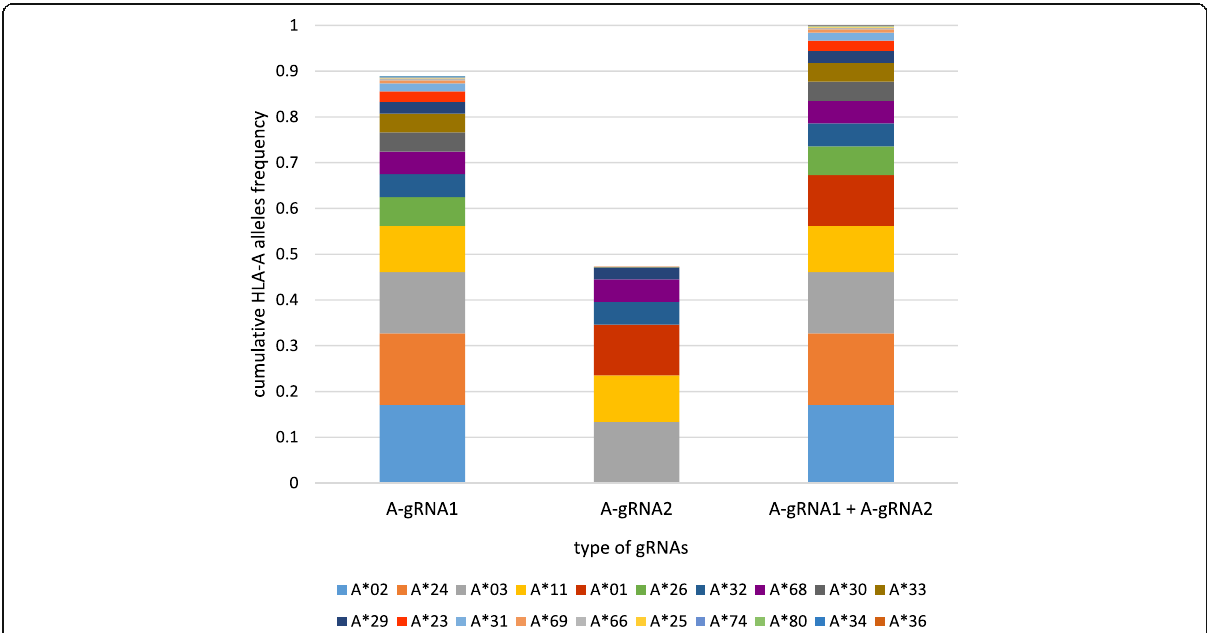
Fig. 2 Coverage of gRNAs for HLA-A alleles based on the frequencies in the Iranian population. Each column represents the possibility of each gRNA binding to its complementarity among HLA-A alleles. Each gRNA cannot be implemented for all ethnicities, so the last bar shows that all HLA-A alleles seem to be covered when both gRNAs are included